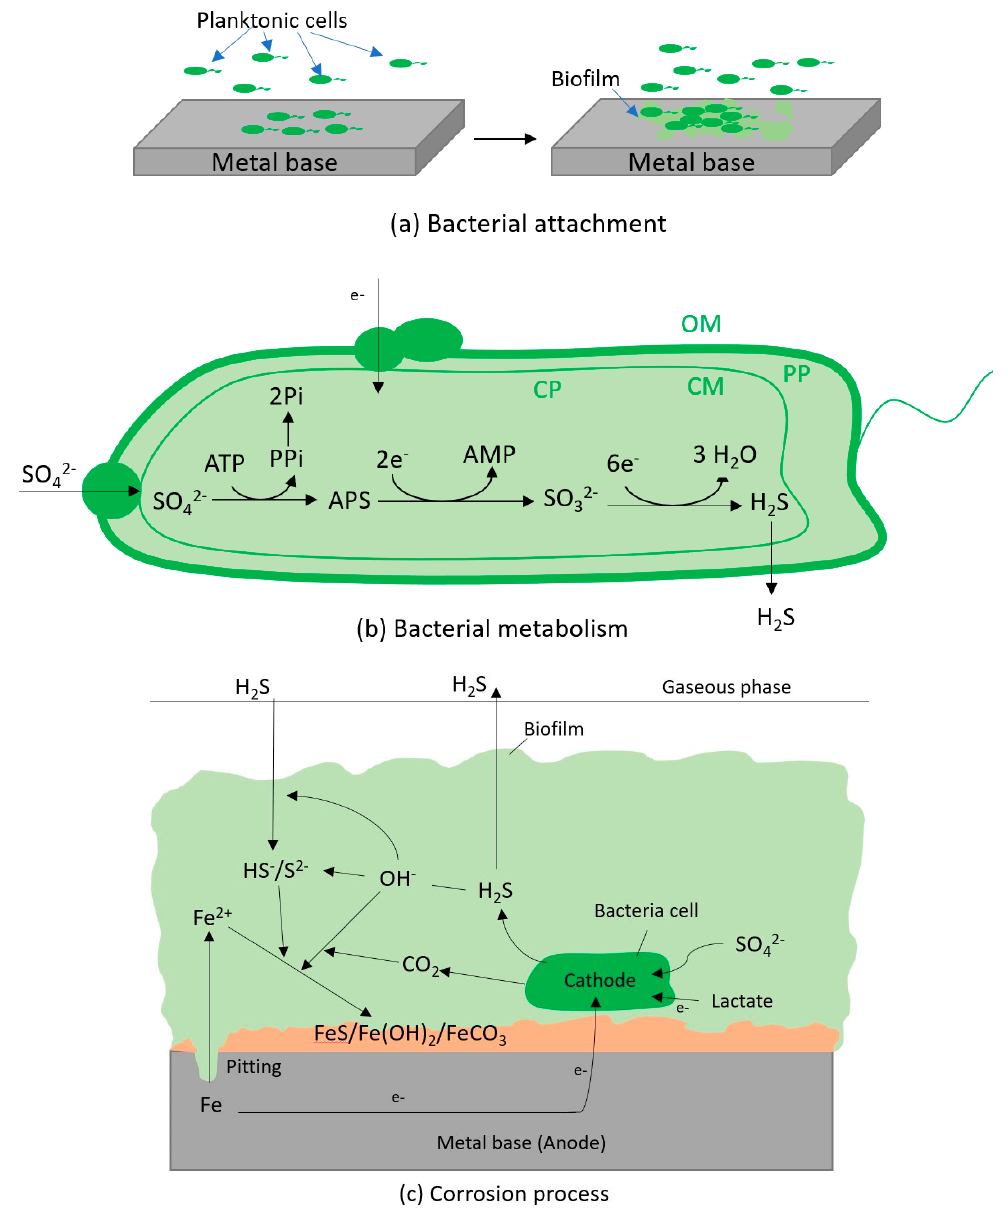
Figure 12. Schematic of changing pH mechanism and corrosion mechanism caused by SRB breakdown by two main steps including adhesion ( a ), bacterial metabolism ( b ) and corrosion process ( c ); bacterial metabolism including specific proteins in the outer membrane (OM), periplasm (PP) and cytoplasmic membrane (CM) allow electron go through for sulphate reduction process in the cytoplasm (CP); corrosion process including the production of hydrogen sulphide (H 2 S) produced by bacterial metabolism which consumes electron from iron and lactate (nutrient) and the combination of iron ion with sulphide and hydroxide to form corrosion products (FeS/Fe(OH) 2 ).